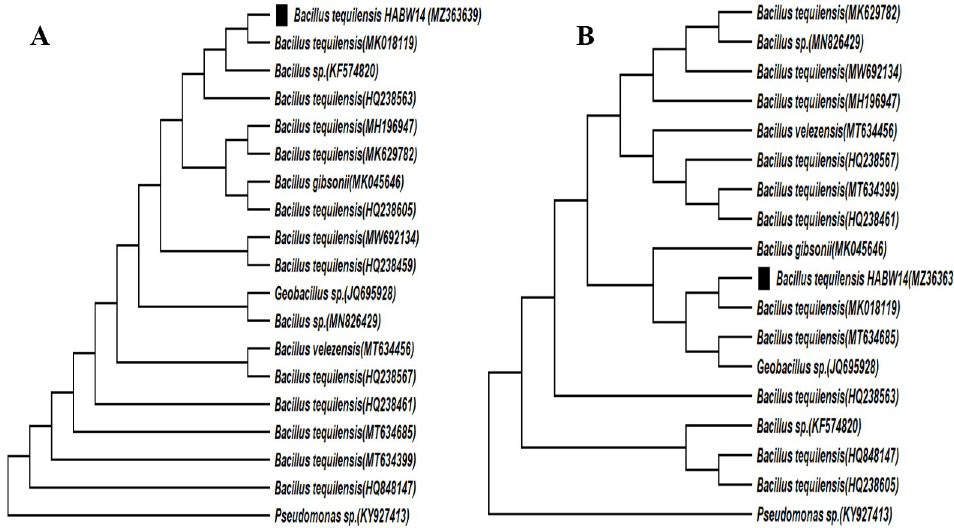
Fig 11. Phylogenetic tree (A: Neighbour-joining method, B: Maximum likelihood method) constructed based on 16S rRNA gene sequences of Bacillus tequilensis HABW14 (MZ363639) and other related sequences retrieved from